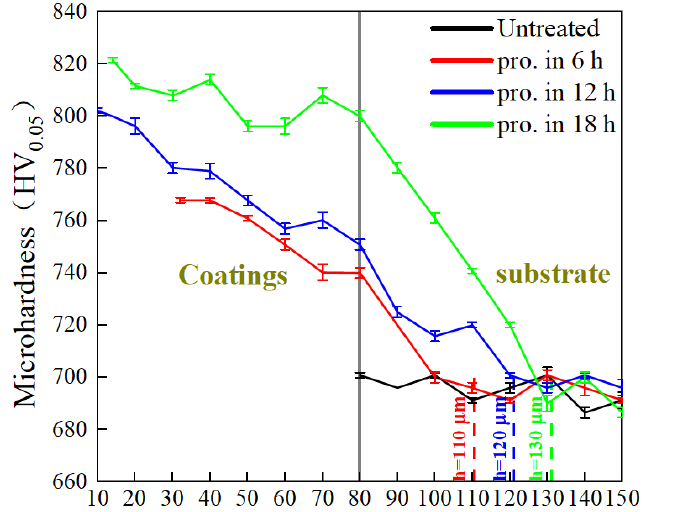
Figure 6. Microhardness profile of the graded coating.